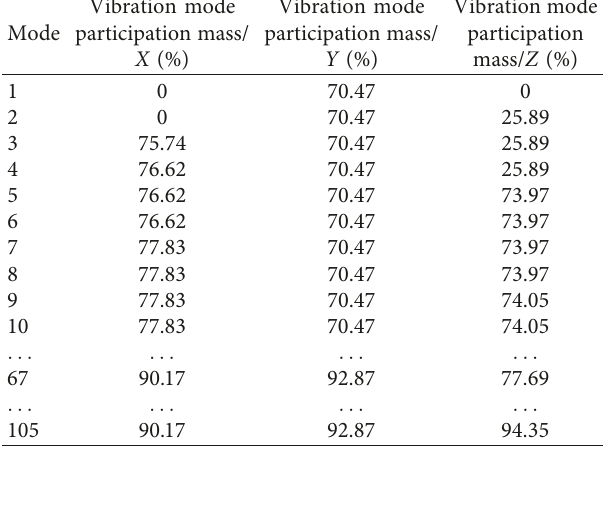
Table 3: Cumulative participation mass of the first 110 vibration modes of the bridge structures.